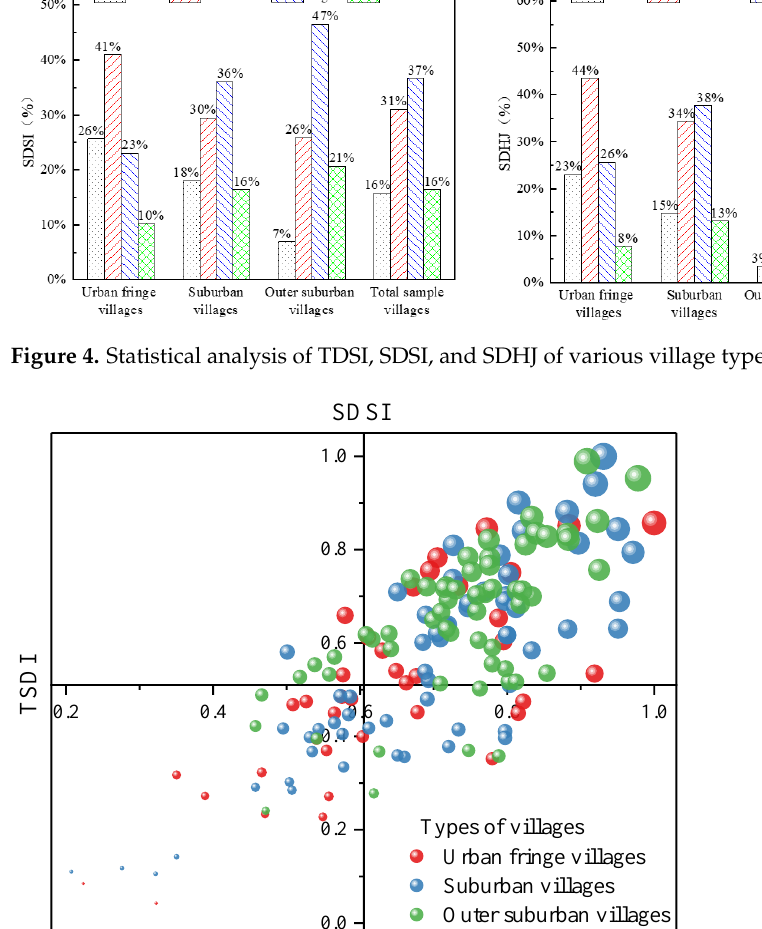
Figure 5. Bubble chart of SDHJ of sample villages in Chongqing.